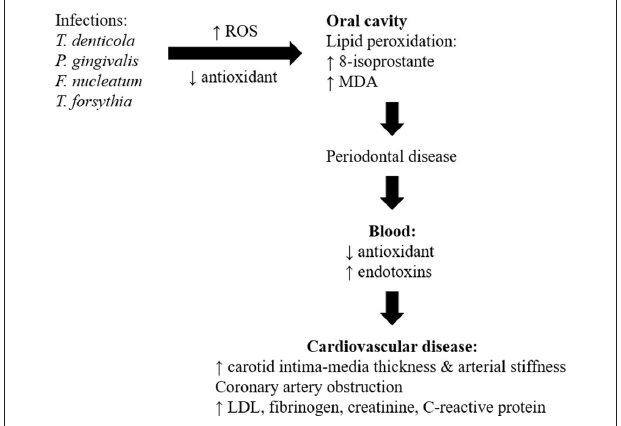
FIGURE 4 | Schematic diagram to show how oral disease may be linked to cardiovascular disease.